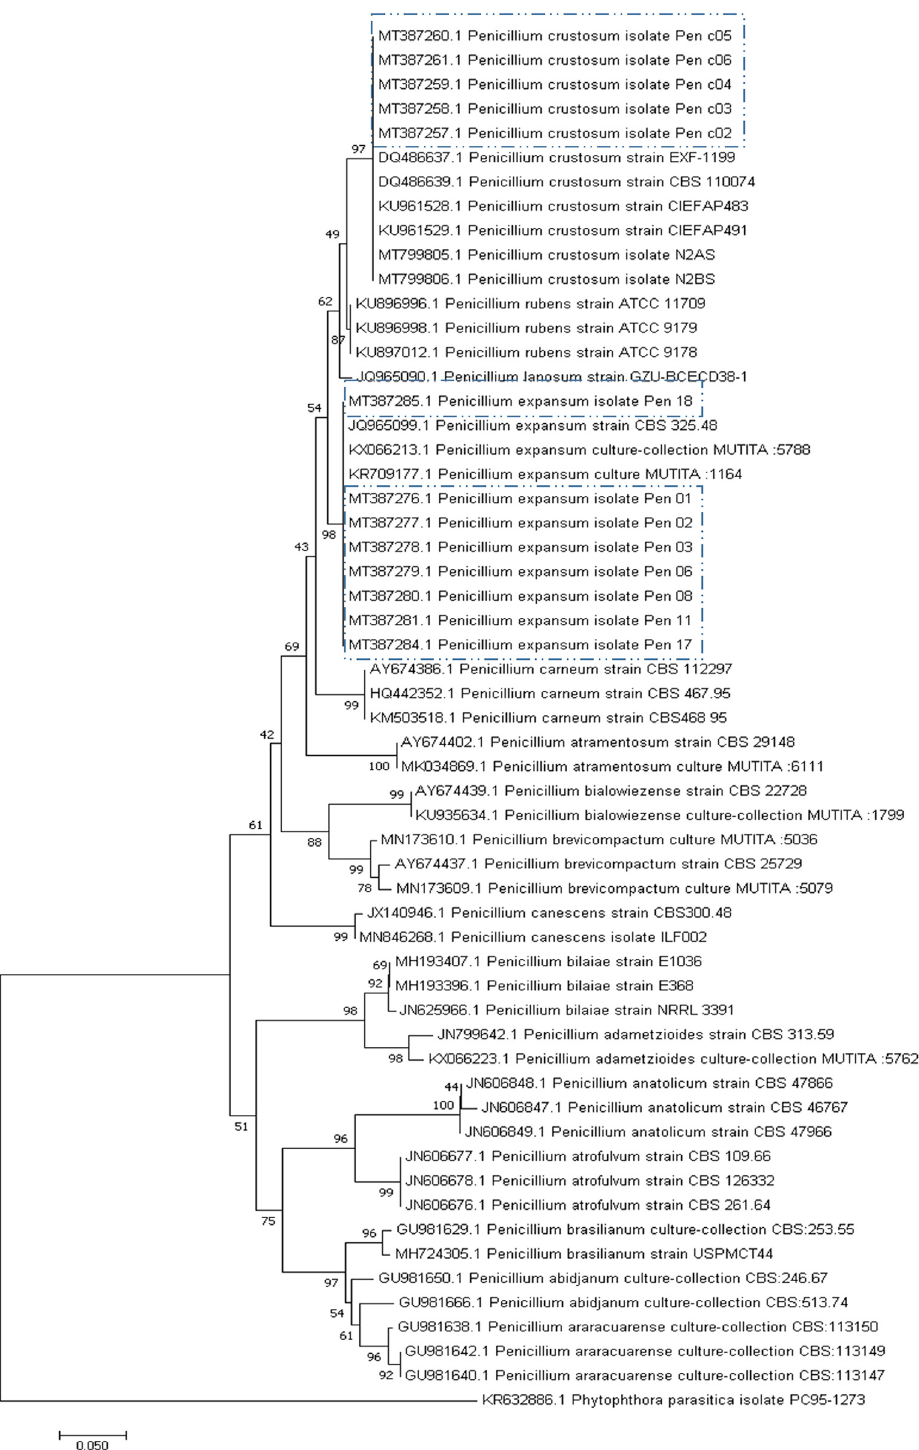
Figure 4: Phylogenetic tree based upon MUSCLE alignment of the β - tubulin region nucleotide sequences of Penicillium isolates causing blue mold of grapes. The evolutionary history was inferred using the neighbour - joining method. The optimal tree with the sum of branch length = 1.55153106 is shown. The percentage of replicate trees in which the associated taxa clustered together in the bootstrap test ( 1,000 replicates ) is shown next to the branches. The tree is drawn to scale, with branch lengths in the same units as those of the evolutionary distances used to infer the phylogenetic tree. The evolutionary distances were computed using the Maximum Composite Likelihood method and are in the units of the number of base substitutions per site. The analysis involved 57 nucleotide sequences. All positions containing gaps and missing data were eliminated. There were a total of 181 positions in the fi nal dataset. Evolutionary analyses were conducted in MEGA7. The tree is rooted with Phytophthora parasitica isolate ( KR632886.1 )